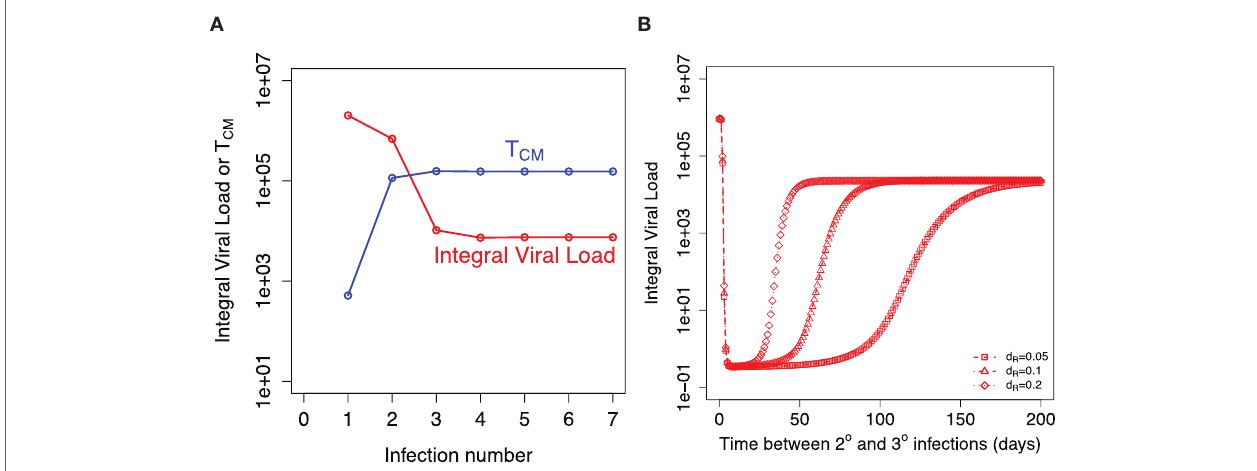
FIGURE 6 | Recall responses to sequential influenza infections . (A) shows how integral viral load and number of central memory T cells ( T M ) depends on the number of influenza infections. The initial amount of T M for each infection is taken from the established equilibrium level values after preceding infection. (B) shows the dependance of integral viral load in tertiary (3°) influenza infection on the time between 2° and 3° infections. The model prediction is shown for three indicated values of the rate of loss of resident memory T cells ( d R